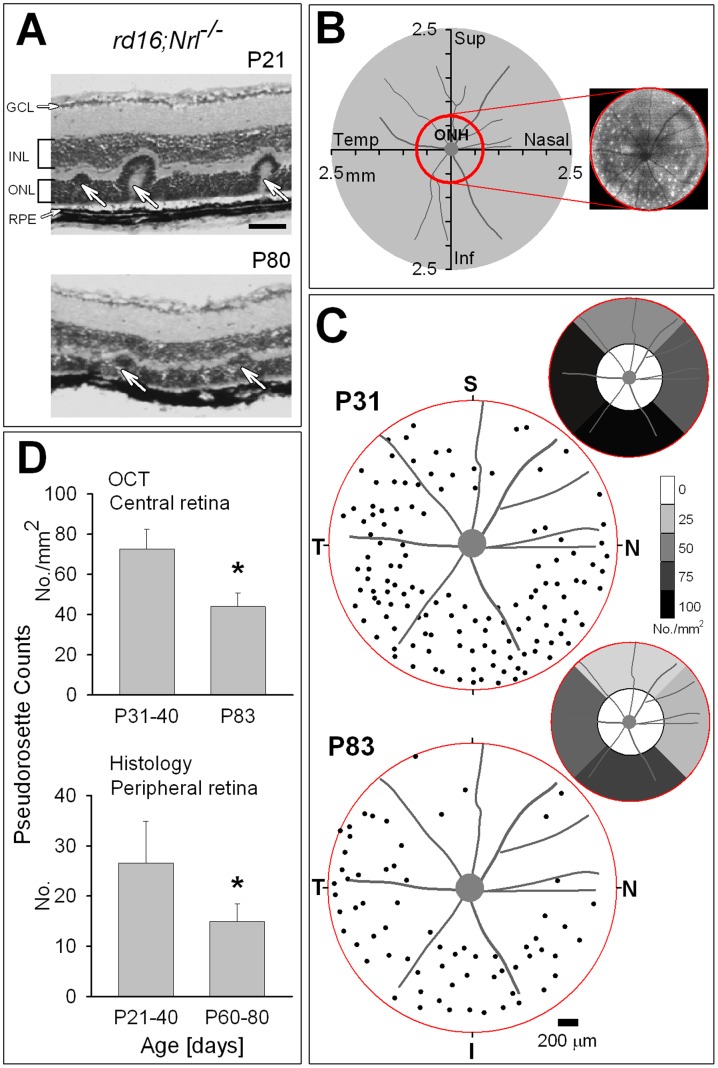
Spatial and temporal distribution of pseudorosettes in rd16;Nrl−/− retina.(A) Histological sections from peripheral retina of two rd16;Nrl−/− mice at different ages demonstrating the presence of pseudorosettes (arrows). Calibration = 50 μm. (B) Schematic drawing of the mouse retina indicating the coverage of the central OCT raster scans (red circle). ONH is centered in the drawing. Integrated en face image of the central region of a P41 rd16;Nrl−/− mouse showing how pseudorosettes appear as white dots (B, right panel, red circle). (C) Pseudorosette distribution within the central retinal region in a young (P31) and an older (P83) rd16;Nrl−/− eyes. Insets (up and right) show average pseudorosettes as density in different sectors of the central retinal region sampled (n = 8 eyes for both age groups). (D) Upper: Histograms comparing number of pseudorosettes in the central retina by OCT at two different ages (P31, n = 10 eyes; P83, n = 8 eyes). Lower: Pseudorosette counts from histological sections of peripheral retina of two different age groups (P21–40, n = 6 eyes; P60–80, n = 6 eyes). Both data sets in rd16;Nrl−/− mice indicate that the number of rosettes decreases with age (*represents p<0.001 and p = 0.01 for the upper and lower graphs, respectively). Error bars, ± SD from the mean.